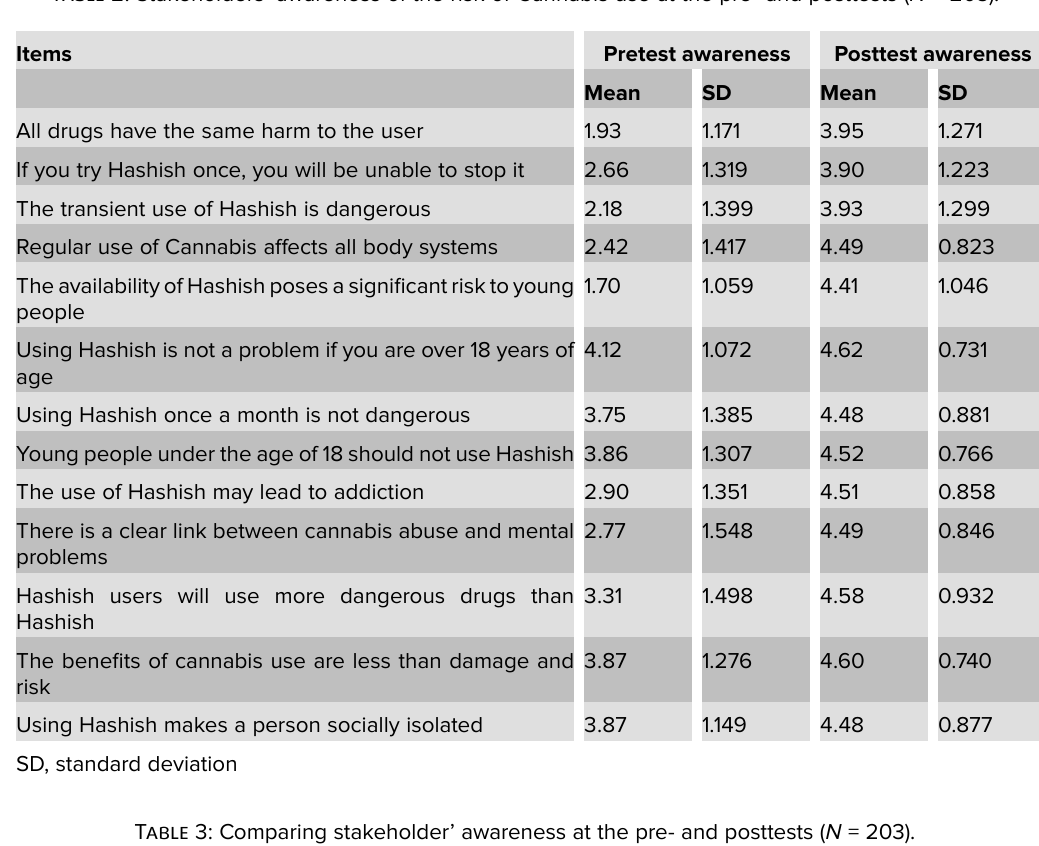
Table 2: Stakeholders’ awareness of the risk of Cannabis use at the pre- and posttests ( N = 203).